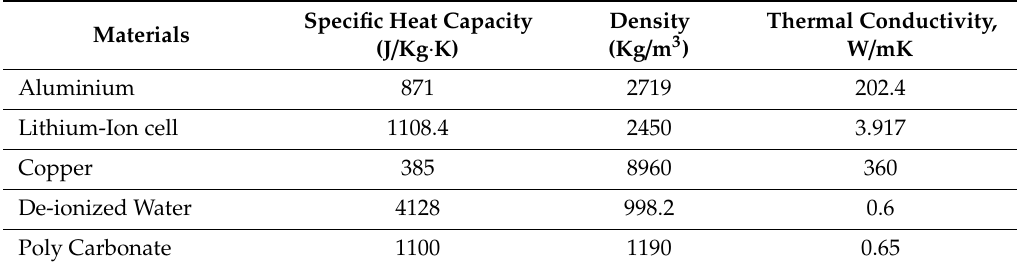
Table 1. Properties of the materials used in the LIB cell